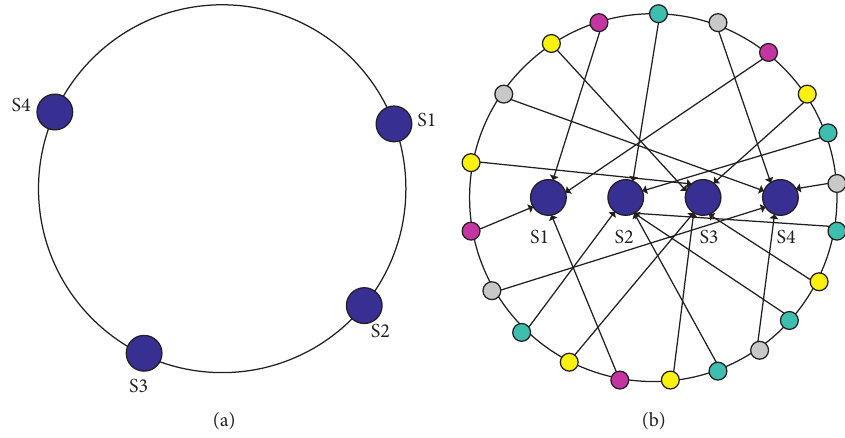
Figure 6: The positional relationship between real nodes and virtual nodes in a hash